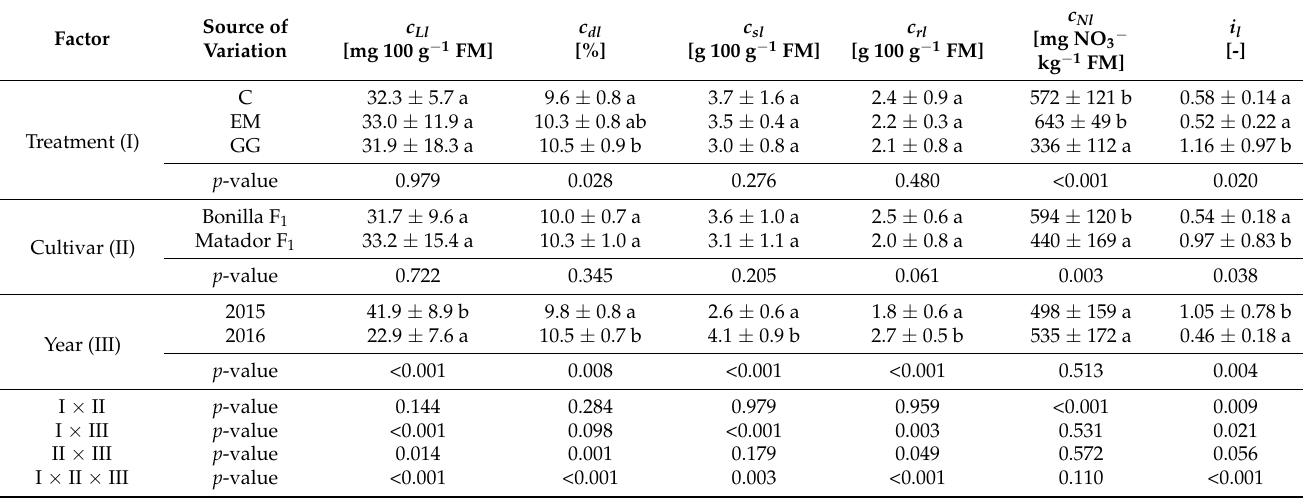
Table 5. Chemical composition of shallot